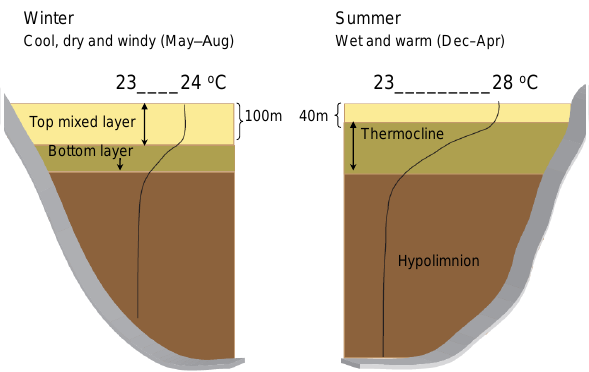
Figure 4. Winter and summer depth and temperature profile for Lake Malawi (mean depth of 273m), Africa (12 ◦ S 35 ◦ E), illus- trated using data from the ILEC world lake database (http://wldb. ilec.or.jp/), showing the three distinct layers (in winter and summer) of a deep stratified non-ice-covered lake. FLake , a two-layer model, predicts the depth and temperature of the “upper mixed layer” and the temperature of the “bottom layer” (shown on the left), and “ther- mocline” depth and temperature profile (shown on the